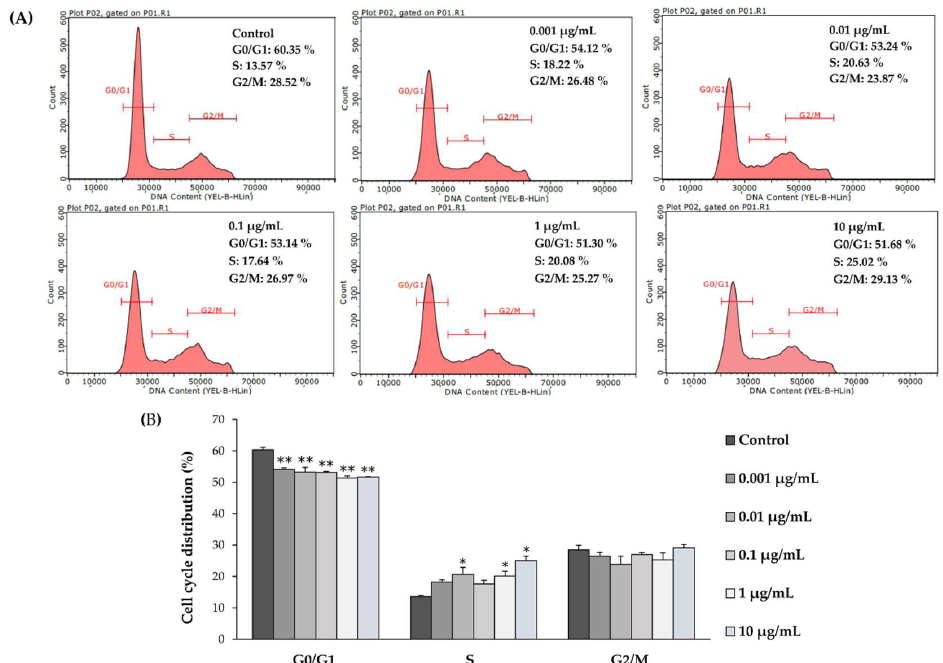
Figure 3. ( A ) The flow cytometry analysis of MC3T3-E1 cells after treatment with L -quebrachitol at concentrations of 0.001, 0.01, 0.1, 1, and 10 µg/mL for 48 h ( B ). The percentage of the total cell population at each phase of the cell cycle is represented by a bar diagram. A representative example of 3 independent experiments. Each data point represents the means of 3 replicate samples ± SEM. * p < 0.05 and ** p < 0.01 when compared with the control.